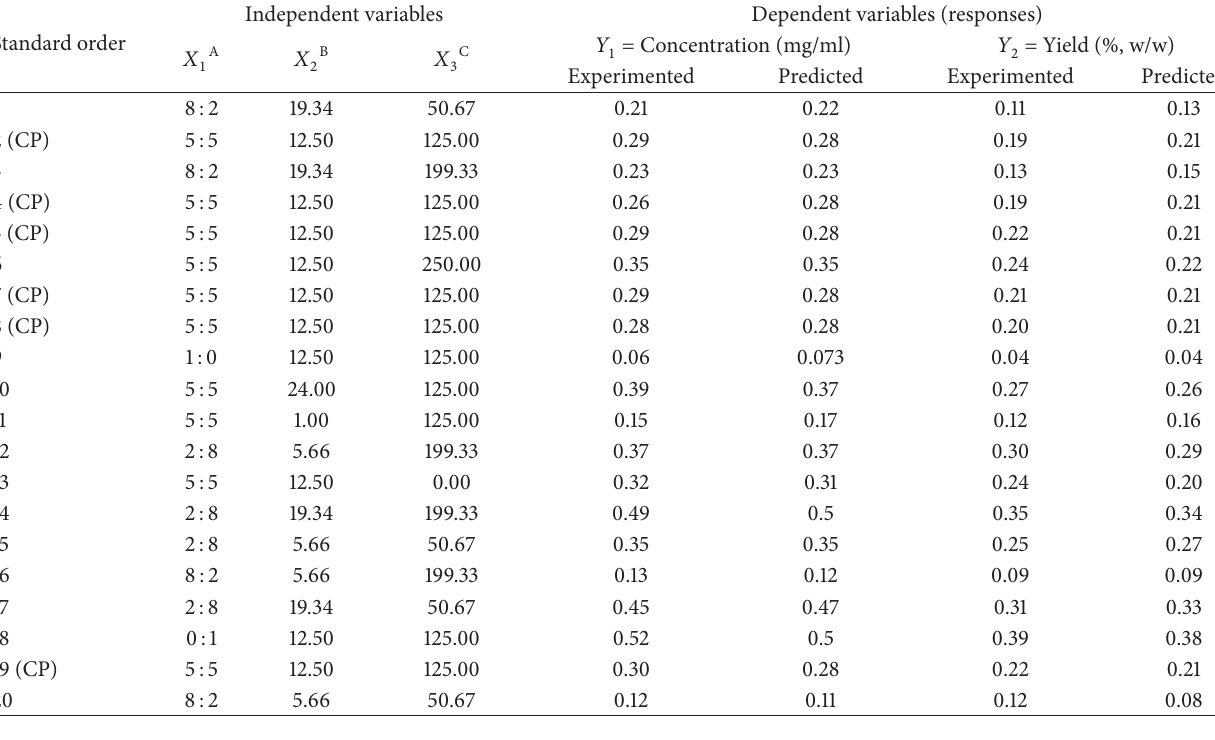
Table 2: Three independent factors with two responses and five levels CCRD with the experimented and predicted values under multiple extraction conditions.